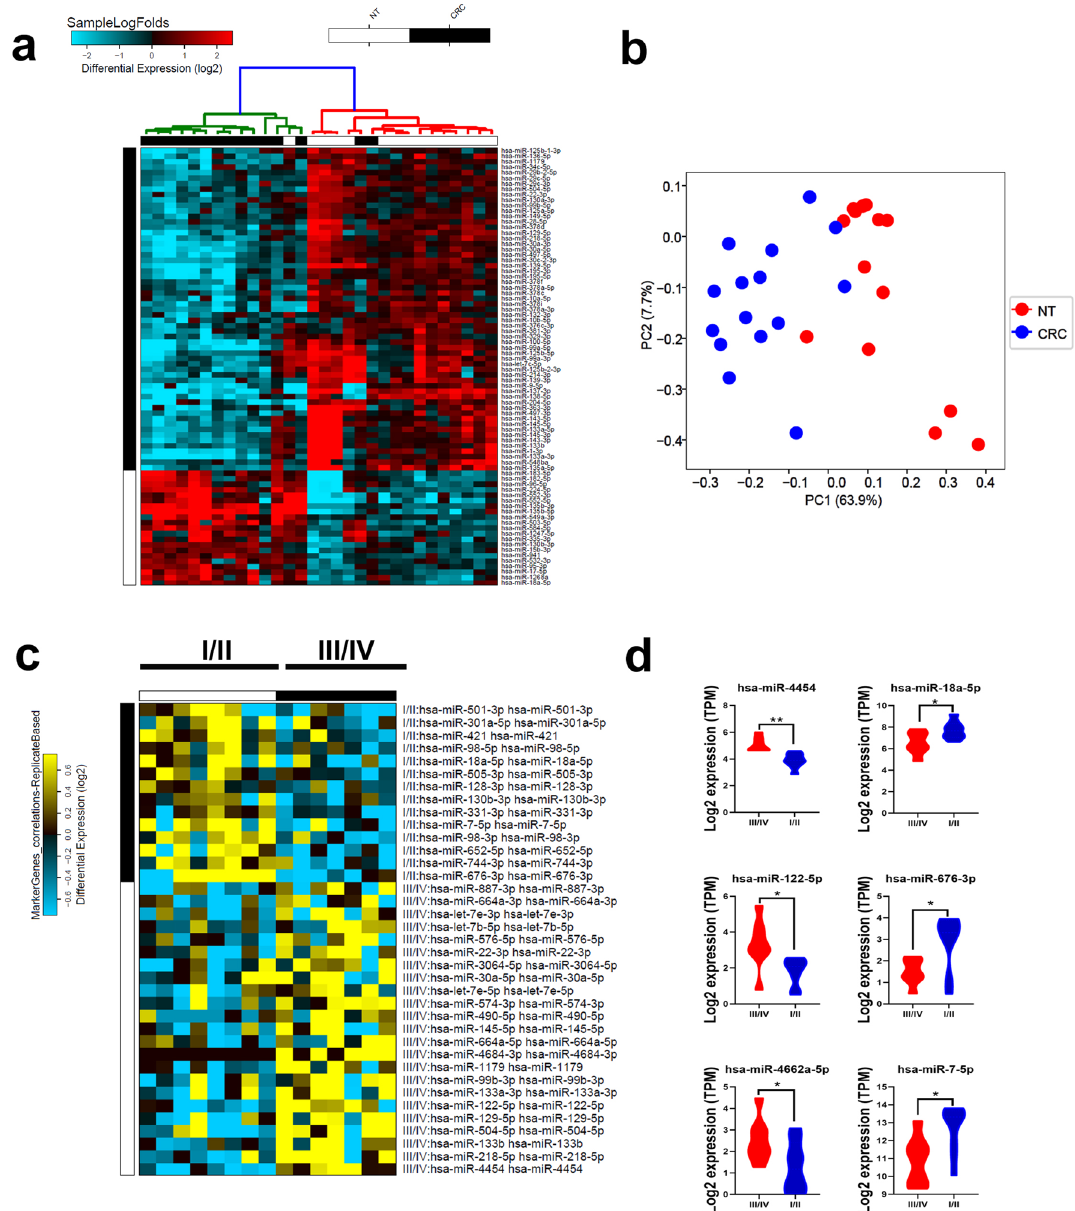
Figure 5. Alteration in miRNA expression in CRC vs. NT. (a) Hierarchical clustering of CRC (n = 15) and adjacent normal tissue (n = 15) based on differentially expressed miRNAs between the two groups. Each column represents one sample and each row represents a miRNA. Expression level of each miRNA (log2) in a single sample is depicted according to the color scale. (b) PCA analysis depicting relatedness of the samples based on PC1 and PC2. (c) Heat map illustrating the most differentially expressed miRNAs in CRC in Stage I/II vs. Stage III/IV. Expression level in each sample is depicted according to the color scale. (d) Expression of three upregulated ( hsa-miR-4454, hsa-miR-122-5p, and hsa-miR-4662a-5p ) and three downregulated ( hsa-miR- 18a-5p, hsa-miR-676-3p, and hsa-miR-7-5p ) in CRC stage III/IV vs. stage mRNAs in CRC and those which were experimentally observed or predicted with high confidence based on IPA analysis which led to the identification of 33 downregulated and 14 upregulated miRNAs and their respected mRNA targets. Visualization of the miRNA-mRNA interactions are depicted using cystoscope (Fig. 6). Starting with hsa-miR-1-3p, the downregulation of this miRNA is predicted to upregulate IQGAP3, SERPINB5, ORC6 (also associated with the downregulation of hsa-miR-136-5p ), and UHRF1 . UHRF1 , along with NME4, MYC, HMGA1, RRM2, and PRSS22 , interact with the downregulated hsa-miR-7c-5p and so on. Figure 6a illustrates in detail, the complex associations and interactions between downregulated miRNAs and upregulated mRNAs in CRC, including several experimentally validated interactions and associations with high confidence according to IPA predictions. Figure 6b shows interactions between upregulated miRNAs and downregulated mRNAs in